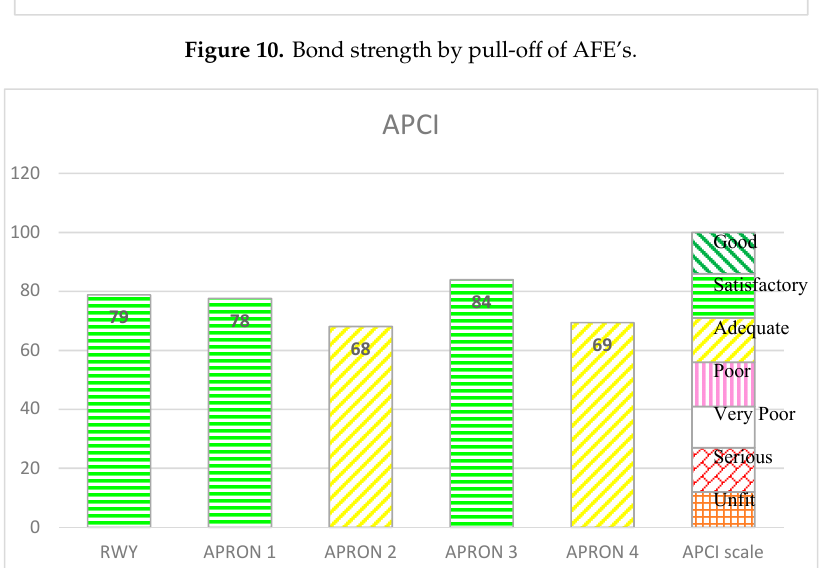
Figure 11. APCI evaluation of AFE’s.